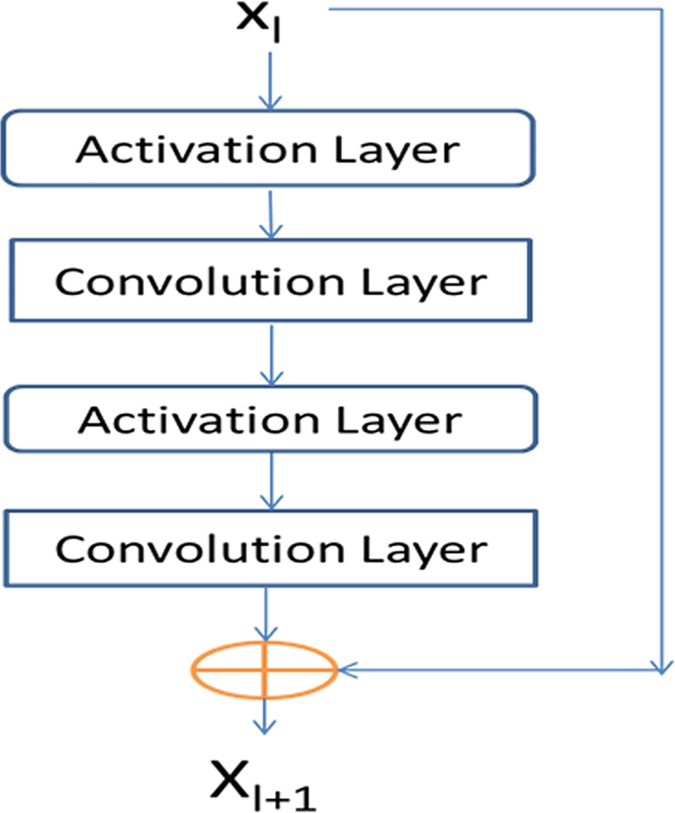
A building block of our residual network with Xl and Xl+1 being input and output, respectively.Each block consists of two convolution layers and two activation layers.